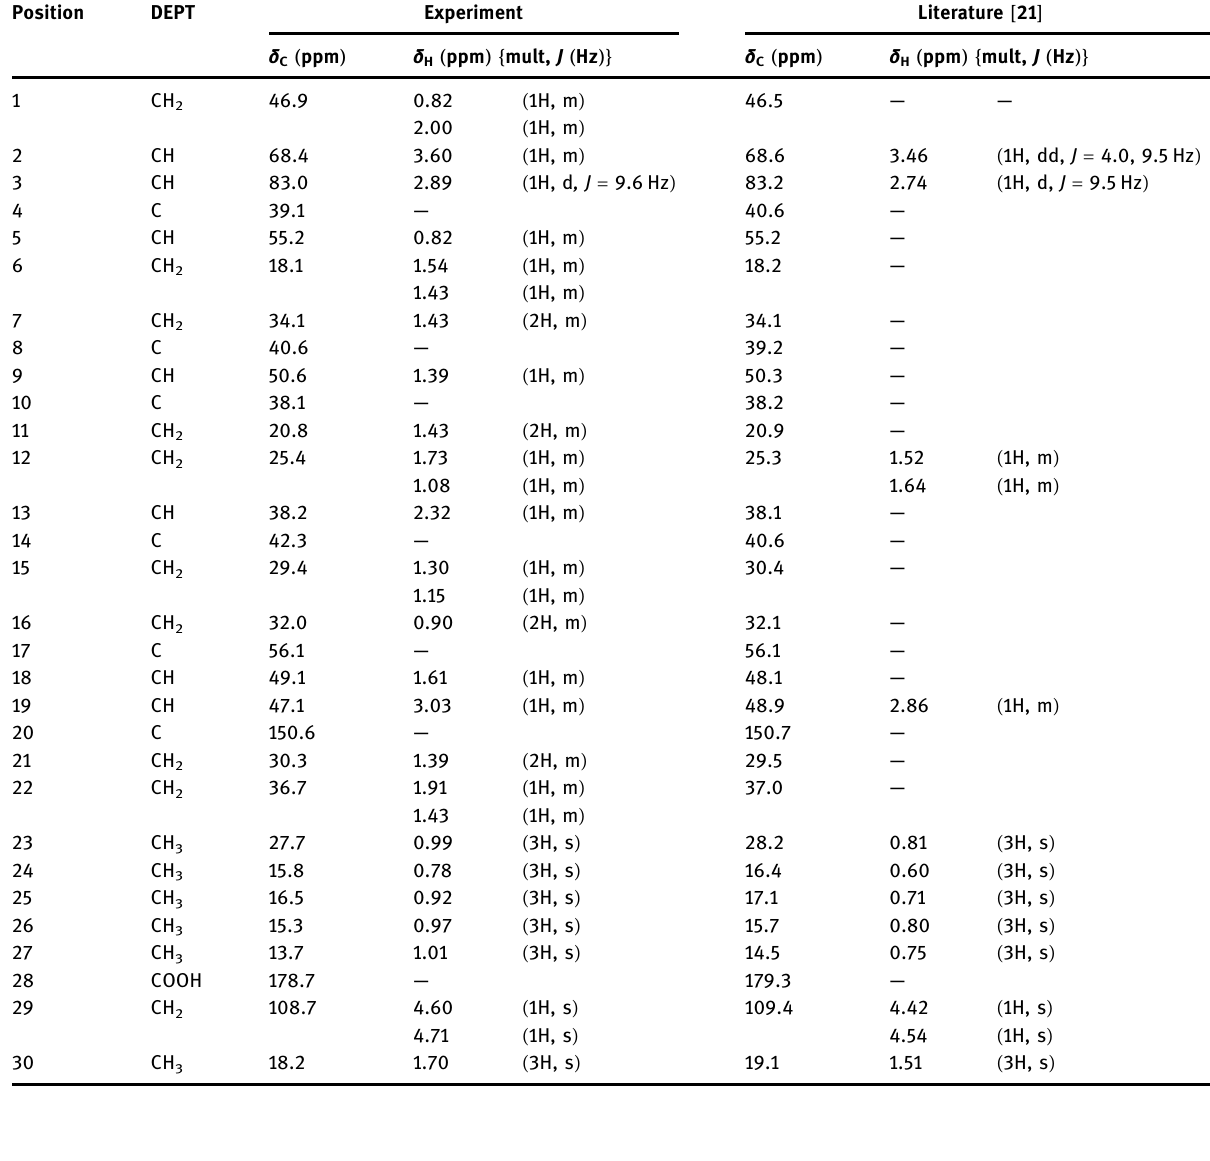
Table 1: NMR spectra of alphitolic acid by comparing to literature Position